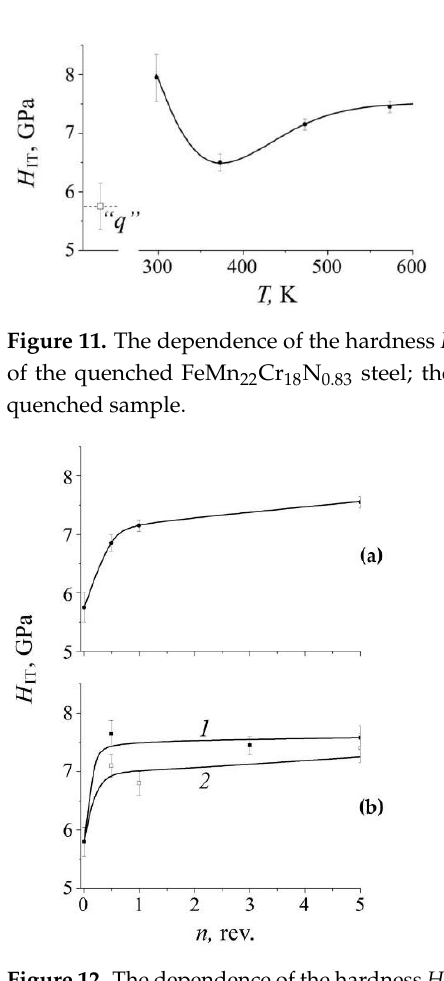
Figure 12. The dependence of the hardness H IT on the degree of deformation ε (number of revolu- tions n ) of the FeMn 22 Cr 18 N 0.83 steel ( a ) quenched at 573 K and ( b ) aged at 1073 K, for 2 h: ( 1 ) — HPT- deformed at 573 K; ( 2 ) — HPT-deformed at 298 K.